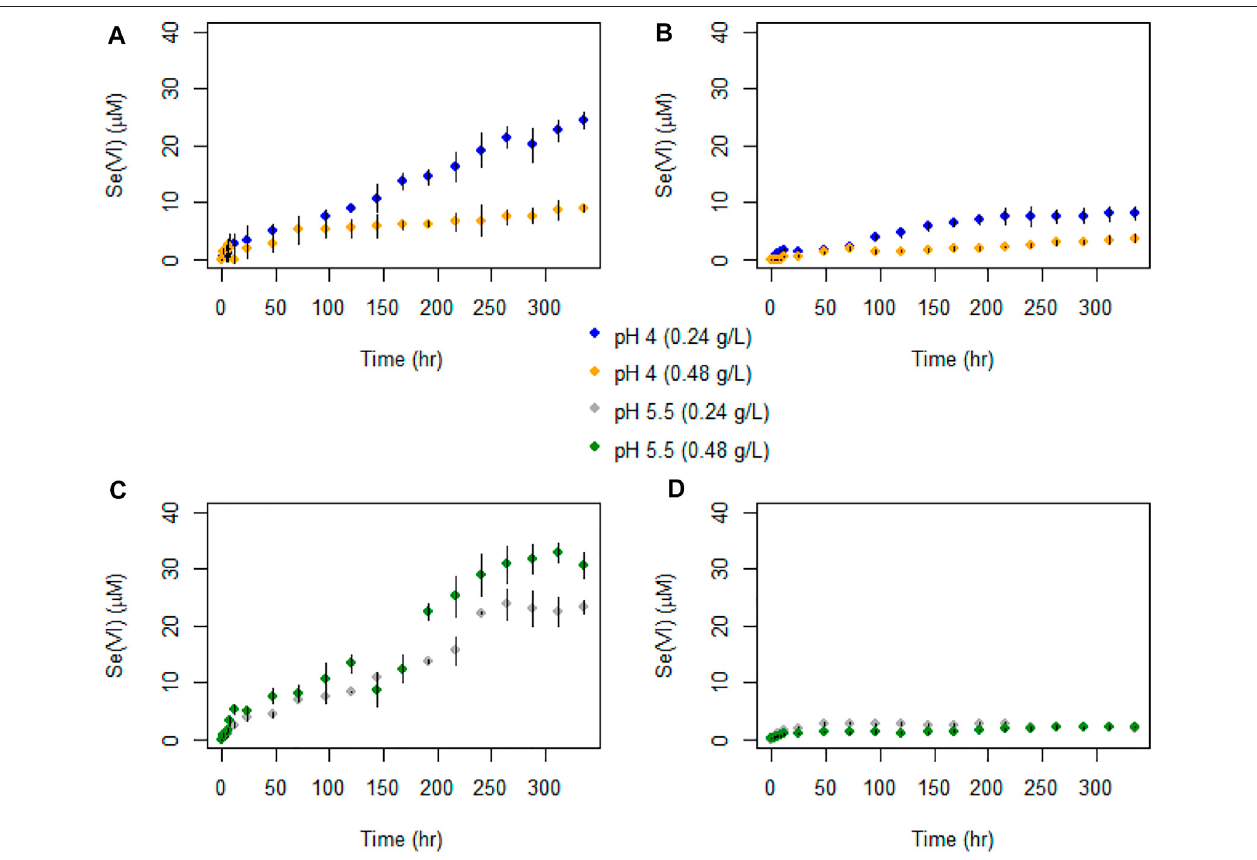
FIGURE5| TemporalevolutionofSe(VI)concentrationsinbatch experiments with (A) ARbirnessite atpH 4, (B) SGbirnessiteat pH4, (C) ARbirnessiteat pH5.5, and (D) SG birnessite at pH 5.5. All experiments were performed at 25 ° C with an initial Se(IV) of 120 μ M. Error bars represent standard deviations for concentrations measured in